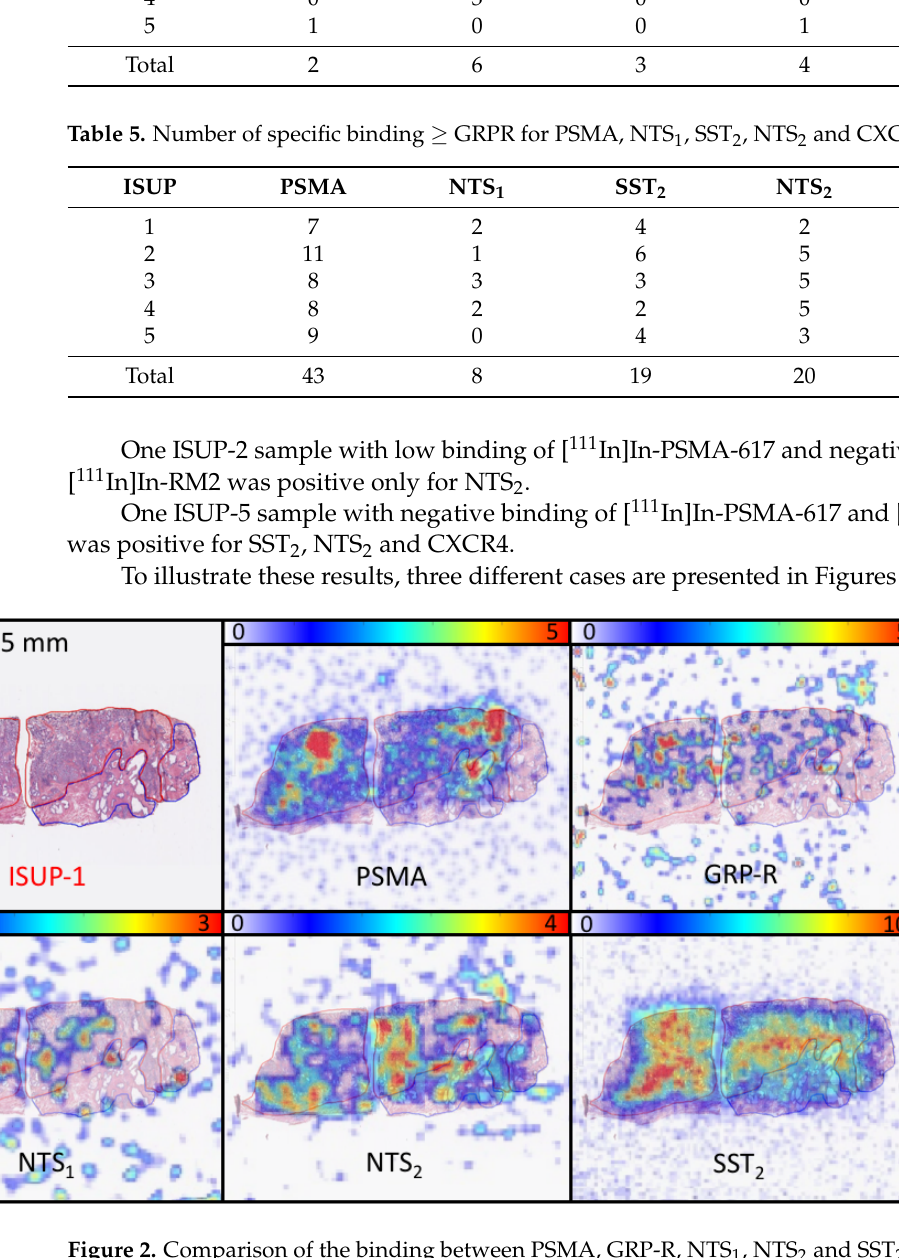
Figure 2. Comparison of the binding between PSMA, GRP-R, NTS 1 , NTS 2 and SST 2 -specific radio- pharmaceuticals on an ISUP-1 sample. The red line drawing on the HES slice corresponds to the tumor area. Specific binding = 92% for PSMA, 90% for GRP-R, 67% for NTS 1 , 92% for NTS 2 and 47% for SST 2 . Color scale refers to cps/mm².